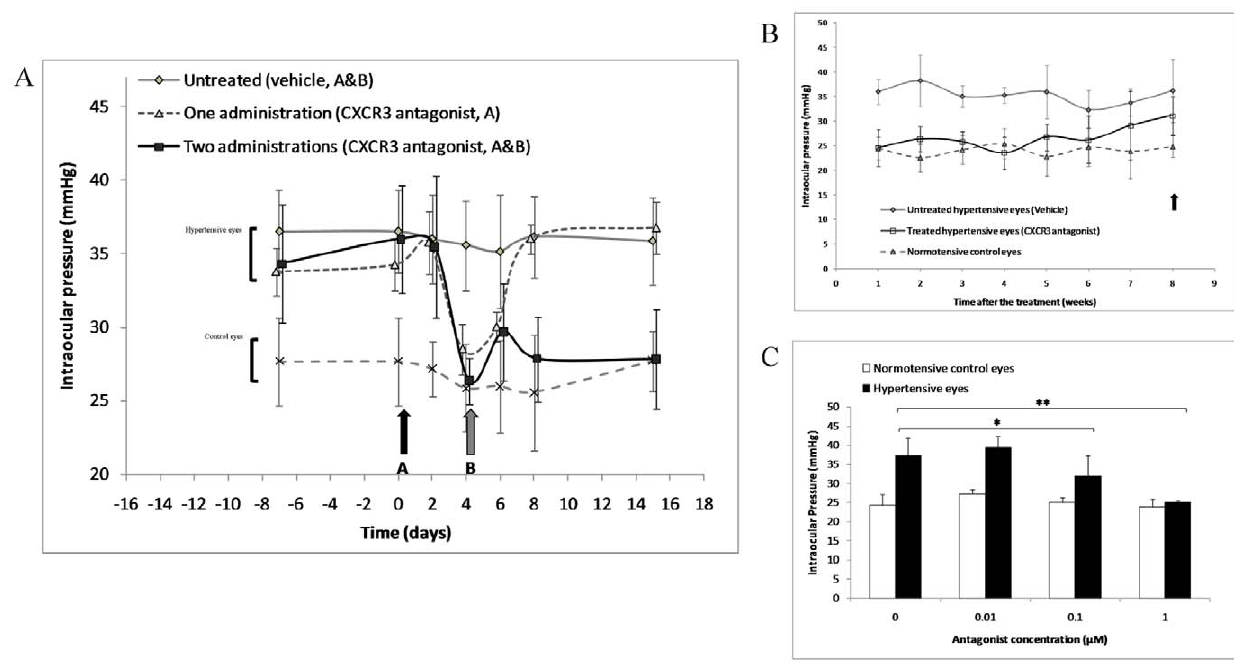
Figure 4. Ophthalmic administration of CXCR3 antagonist decreases intraocular pressure in a rat model of ocular hypertension. (A) A single administration of CXCR3 antagonist (NBI-74330, 1 m M, 100 m L) induces a transient decrease in intraocular pressure (n=10 in each group). (B) When the antagonist is administrated twice, intraocular pressure remains low during 6 weeks (n=10 each); the black arrow indicates the period of retinal and visual in vivo testing presented in Fig. 6A,B . (C) Dose-dependent effect of two administrations of CXCR3 antagonist on intraocular pressure as tested two weeks after the treatment (n=5 each). * P , 0.05, ** P , 0.01. Data in graphs are presented as means 6 SEM. doi:10.1371/journal.pone.0037873.g004 retinal degeneration, we report a decrease in the AH outflow together with a decrease in the trabecular filtrating function, apoptotic loss. In this animal model of OHT and OHT-related suggesting thatlong-termOHTwasduetolateandstabletrabecular